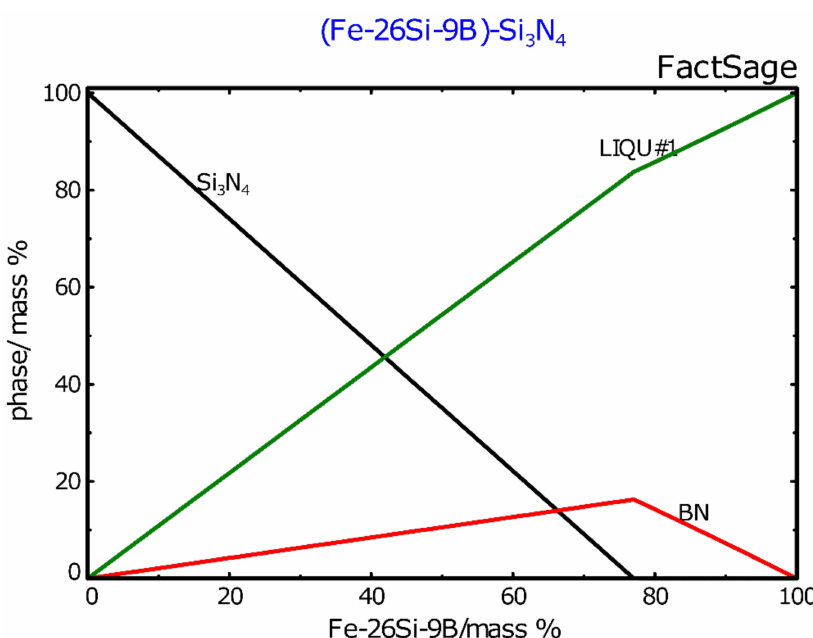
Figure 9. Images of the interface close to the Si 3 N 4 part: ( a ) 3000X; ( b ) 6000X.